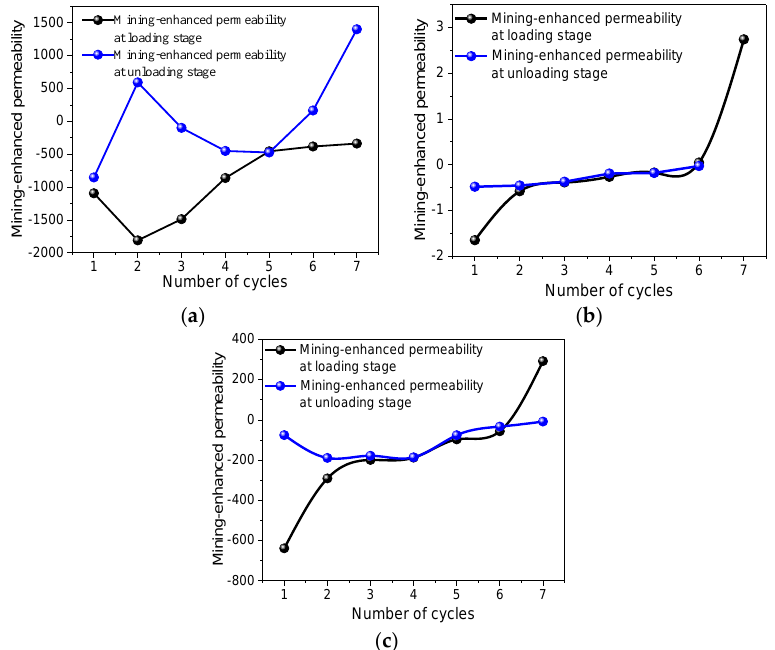
Figure 15. Changes in the mining-enhanced permeability of coal samples under different cyclic loading–unloading paths. ( a ) Stress path 1. ( b ) Stress path 2. ( c ) Stress path 3.